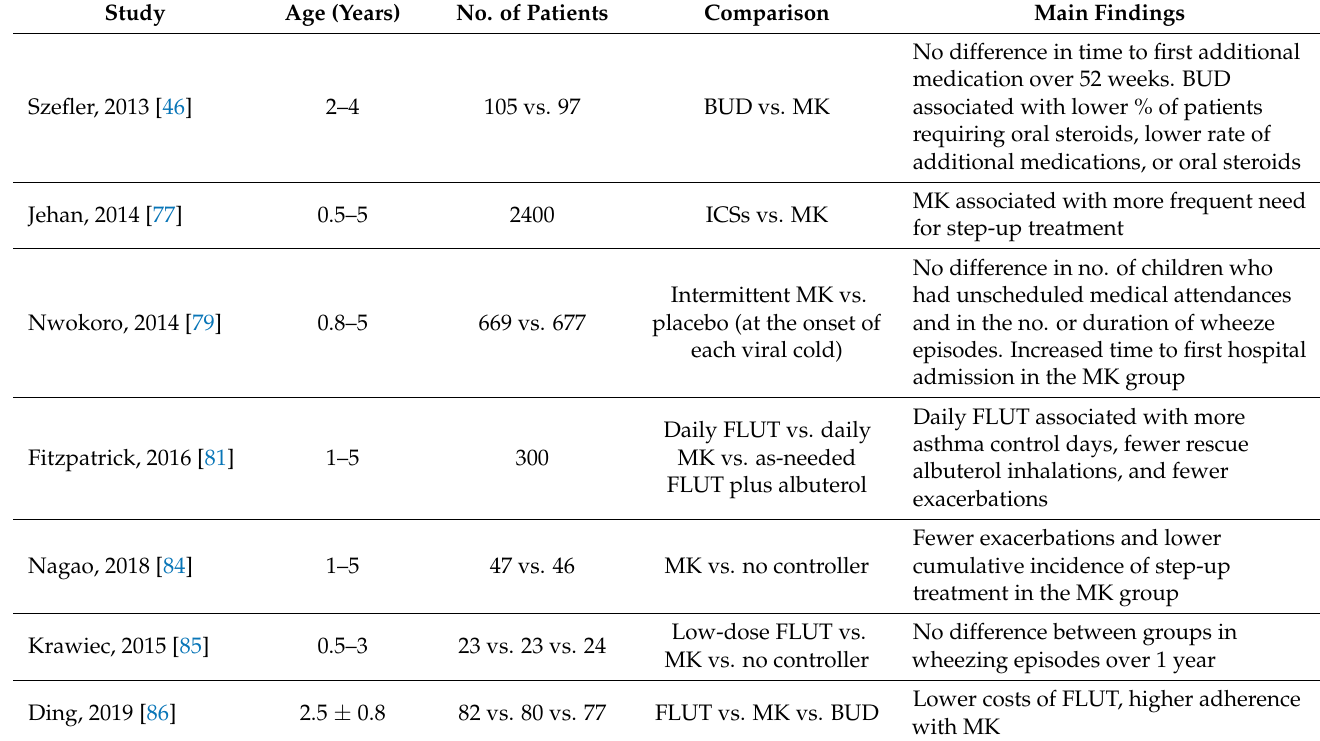
Table 1. Studies published since 2010 comparing montelukast to other controller options in preschool